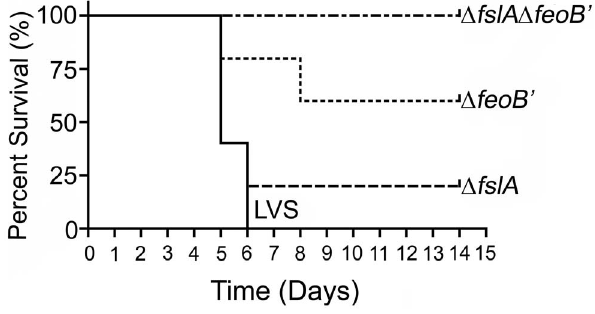
Figure 6. The D fslA D feoB 9 strain is attenuated in virulence. 7- week-old C57BL/6 mice (5 per group) were infected by the intraperitoneal route with 1000 CFU of frozen stocks of bacterial strains. CFU administered were determined by plating on MHA + with additional supplementation of F. tularensis siderophore for growth of the D fslA D feoB 9 mutant. The difference in survival curves of LVS D feoB 9 and LVS D fslA D feoB 9 relative to LVS was statistically significant, p , 0.05 and p , 0.01, respectively. Survivors were challenged with 1000 CFU LVS at day 14 and all mice survived for greater than 14 days.